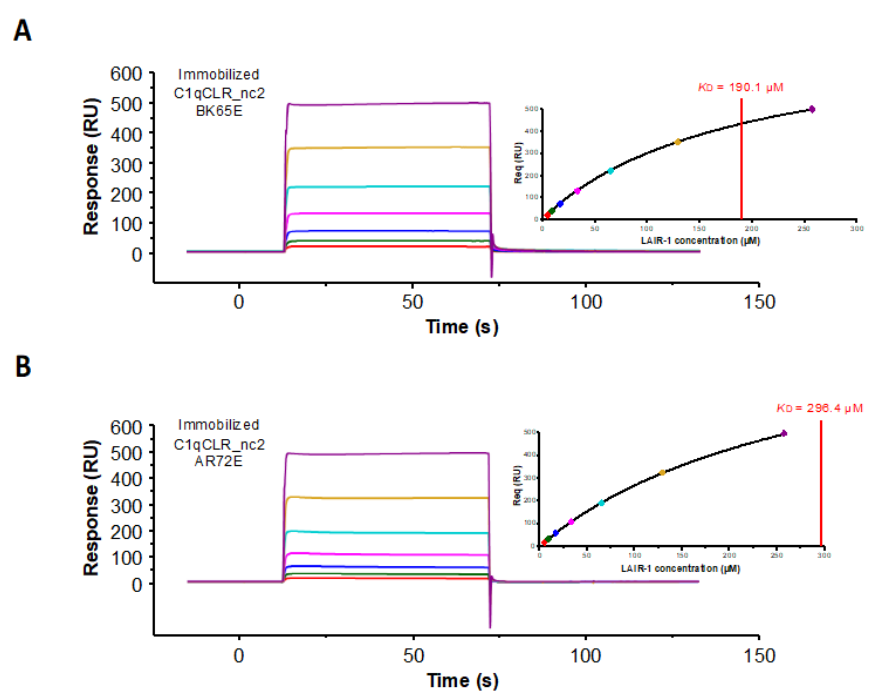
Figure 9. Kinetic analysis of LAIR-1 interaction with immobilized C1qCLR_nc2 variants. LAIR-1 was injected at increasing concentrations (4–256 µ M, 2-fold serial dilution) over immobilized C1qCLR_nc2 B_K65E ( A ) and C1qCLR_nc2 A_R72E ( B ). Fits obtained by a global fitting of the data to a steady-state model are shown in the top right corner of each panel. The results shown are representative of three separate experiments (see Table